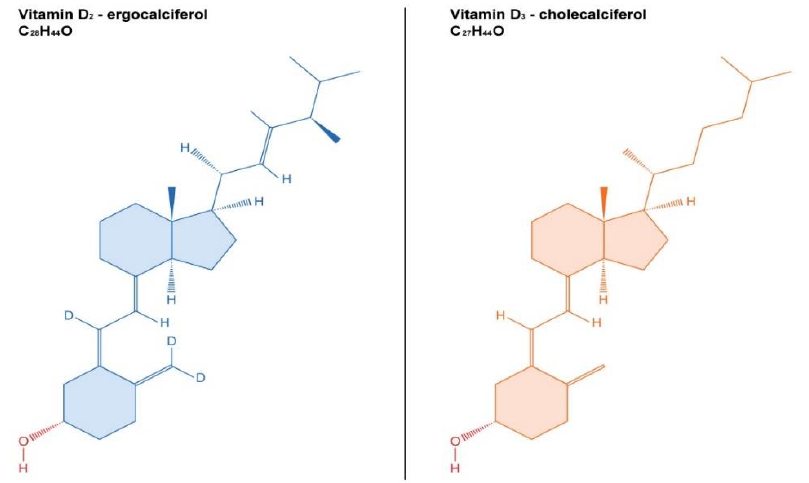
Figure 1. Chemical structure of the vitamin D2, ergocalciferol (C 28 H 44 O), and vitamin D3, cholecal- ciferol (C 27 H 44 O).